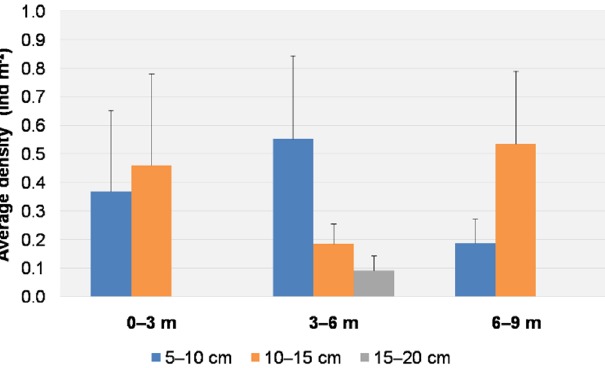
Figure 6. Average density (+S.E. as vertical bar) of Cassiopea andromeda individuals for each size class per depth range.